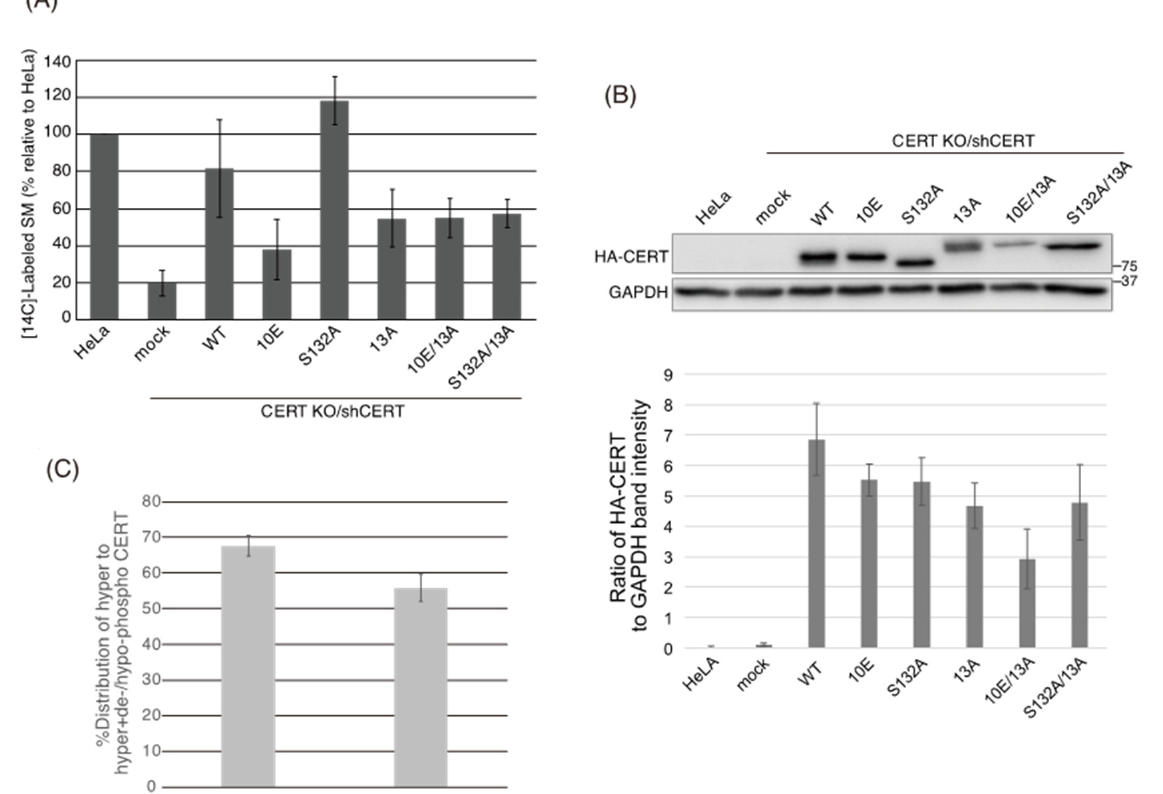
Figure 2. Alanine substitutions for the basic amino acid cluster in the CCR abrogate the down-regulatory effect of the CERT 10E mutation on the de novo synthesis of SM. ( A ) The indicated CERT constructs (please note, an empty vector was used for the mock situation) were stably expressed in HeLa CERT KO/shCERT cells. “HeLa” represents HeLa/mCAT-1 cells that were used as the wild-type control HeLa cells. SM synthesis in these cells was measured by [ 14 C]serine incorporation after incubation for 24 h. Results are the mean and SEM of three experiments. ( B ) Total cell lysates from the indicated cells were analyzed by western blotting with anti-HA and anti-GAPDH antibodies. The ratios of HA-CERT band intensity to GAPDH band intensity calculated from three experiments are shown as bar graphs. ( C ) The signal intensity of the bands corresponding to the hyper-phosphorylated and de-/hypo-phosphorylated forms of CERT WT and CERT 13A was quantified using ImageJ software [24], and the percentage distribution values of their hyperphosphorylated forms were estimated from three independent experiments, as described in the legend to Figure